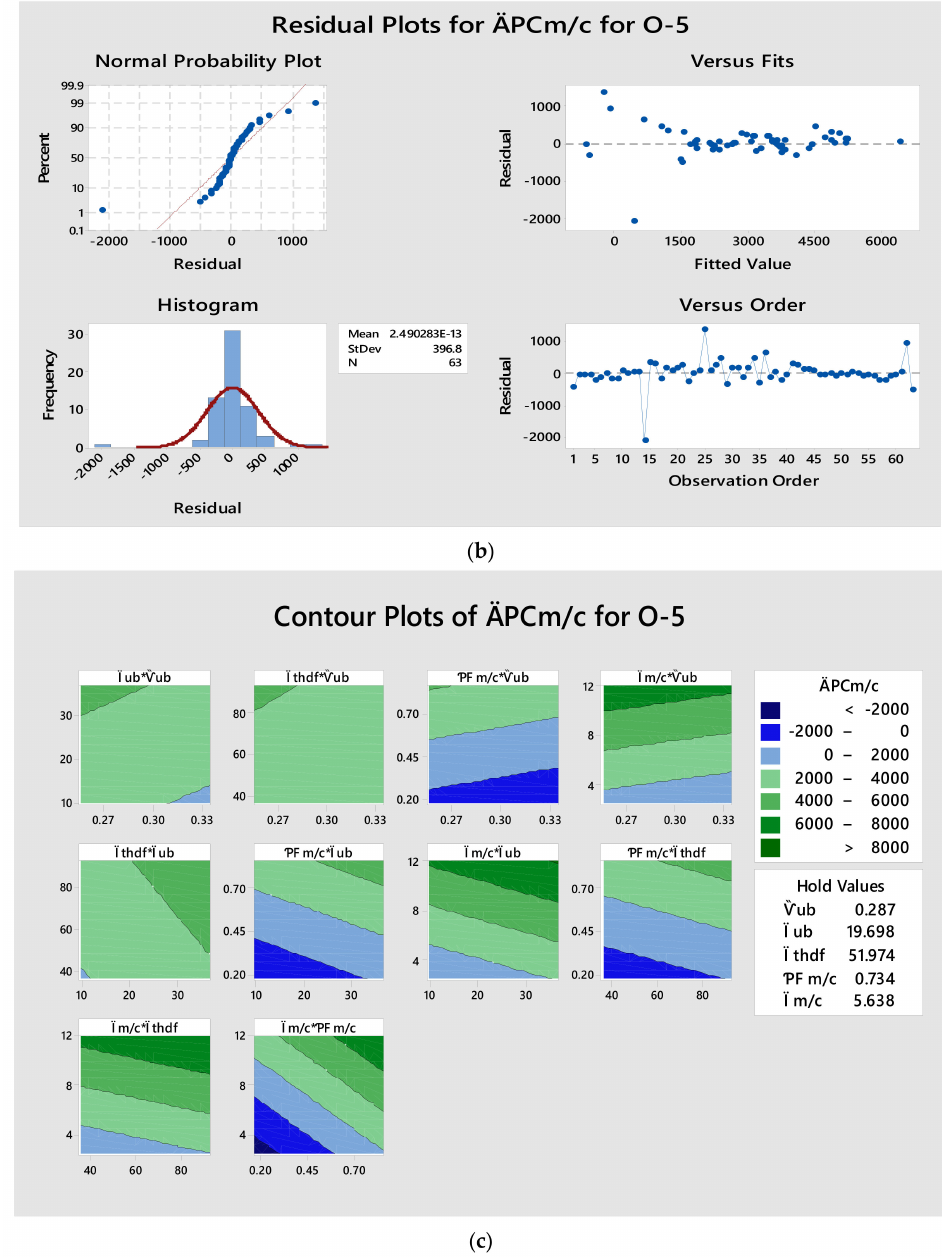
Figure 8. ( a ) Main effects plot for O-5. ( b ) Residuals plot for O-5. ( c ) Contour plots for